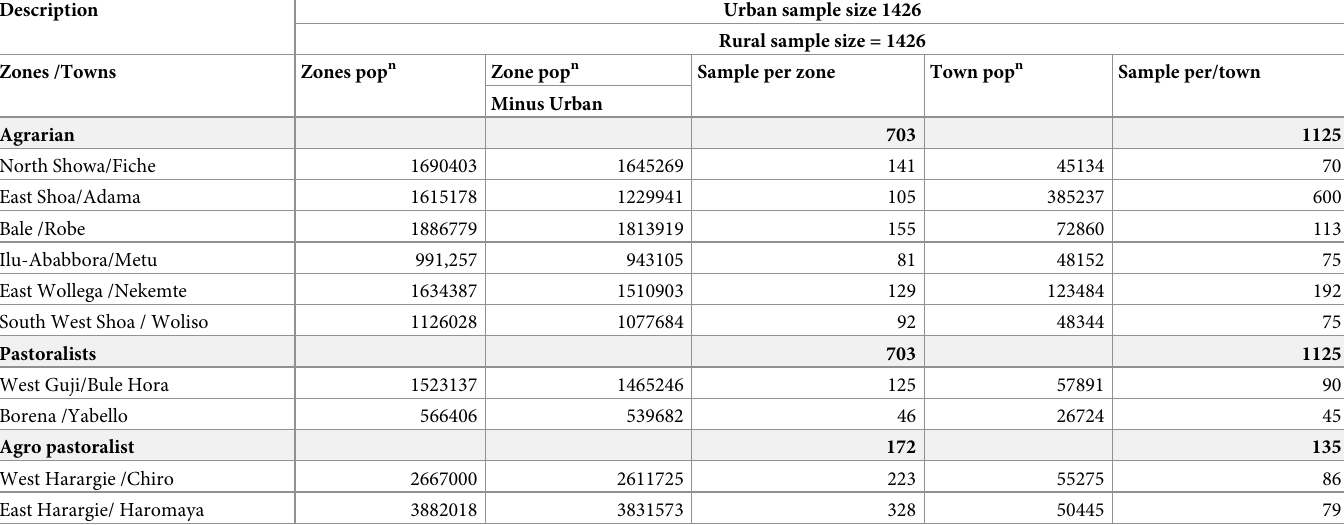
Table 1. Proportion of sample size allocated to zones and towns of the study area, Oromia region, September 2020 to March 2021.